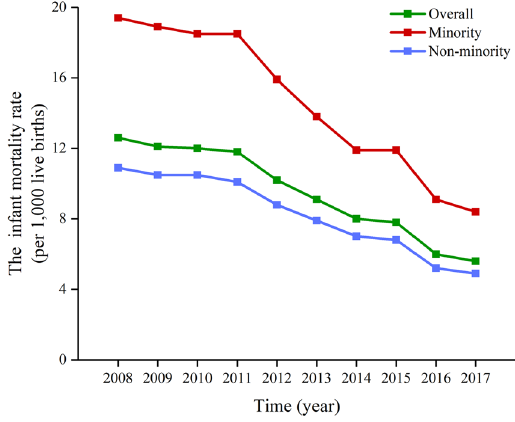
Figure 3. The time trend of IMR in Sichuan Province.